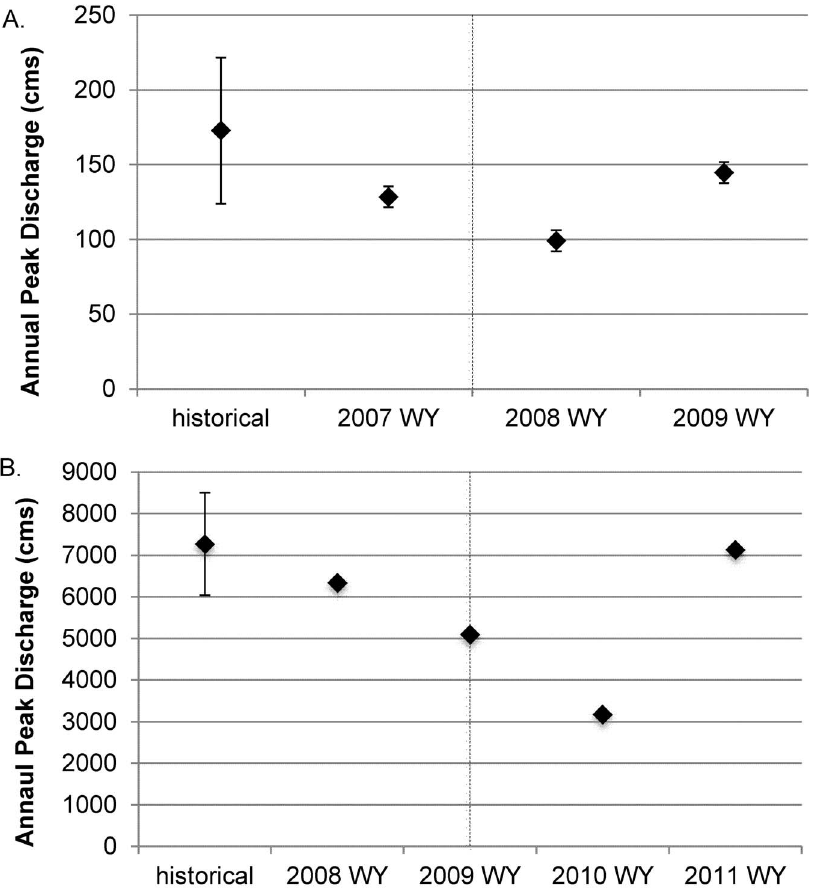
Figure 2. Annual peak discharge for the historical period of record and over the study period for the a) Calapooia at Holley, located 16 km upstream of Brownsville Dam, and b) Rogue River at Grants Pass located 8.6 km downstream of Savage Rapids Dam. Error bars on historical annual peaks represent 2 standard errors. Error bars for the Calapooia River for study years reflect estimation error associated with multiple regression estimate of peak discharge. Vertical dashed lined indicates approximate date of dam removal.